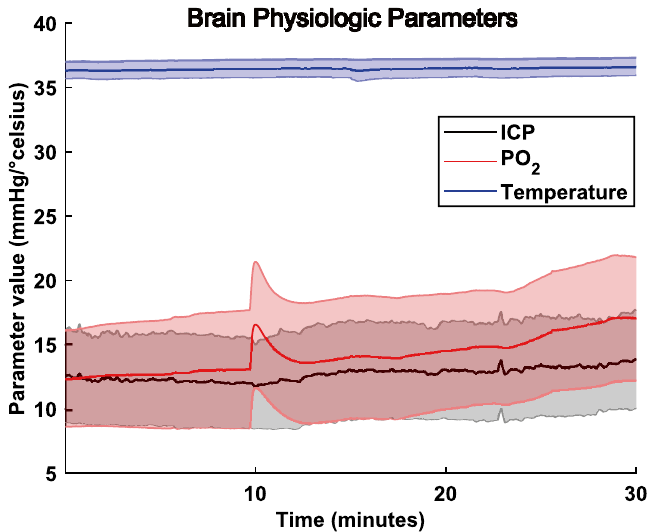
Figure 1. Cerebral viability under anesthesia. Barometric pressure (blue spectra), partial pressure of oxygen (red spectra) and temperature (blue spectra) in the brain of 10 pigs for a period of 30 min. The traces represent mean (dense color lines) and standard deviation ranges (same but lighter color lines).